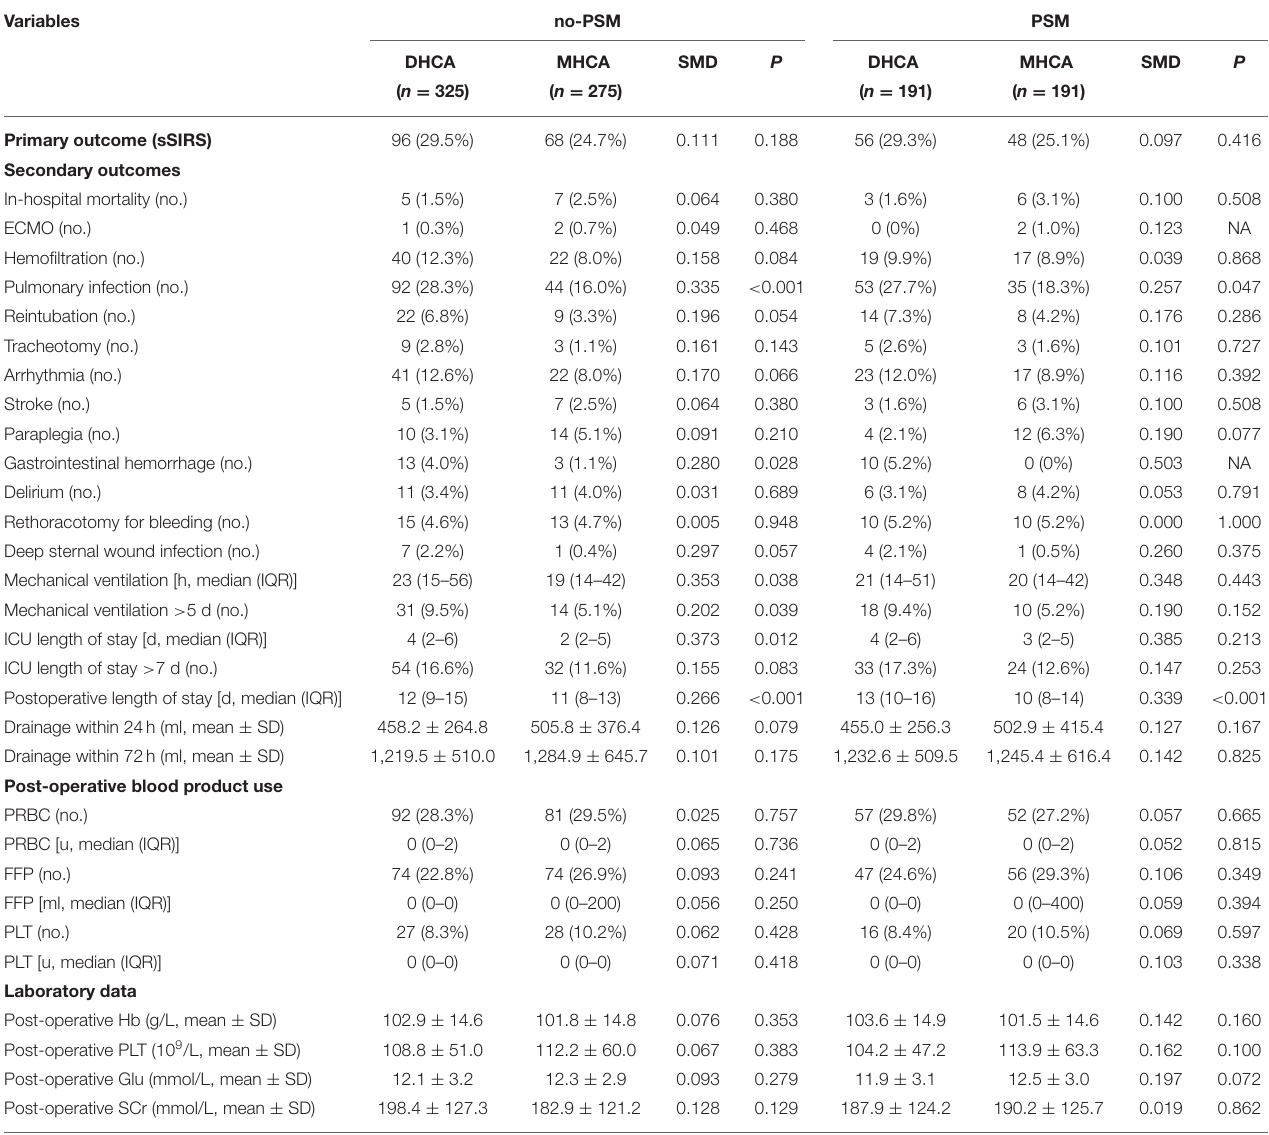
TABLE 4 | Post-operative